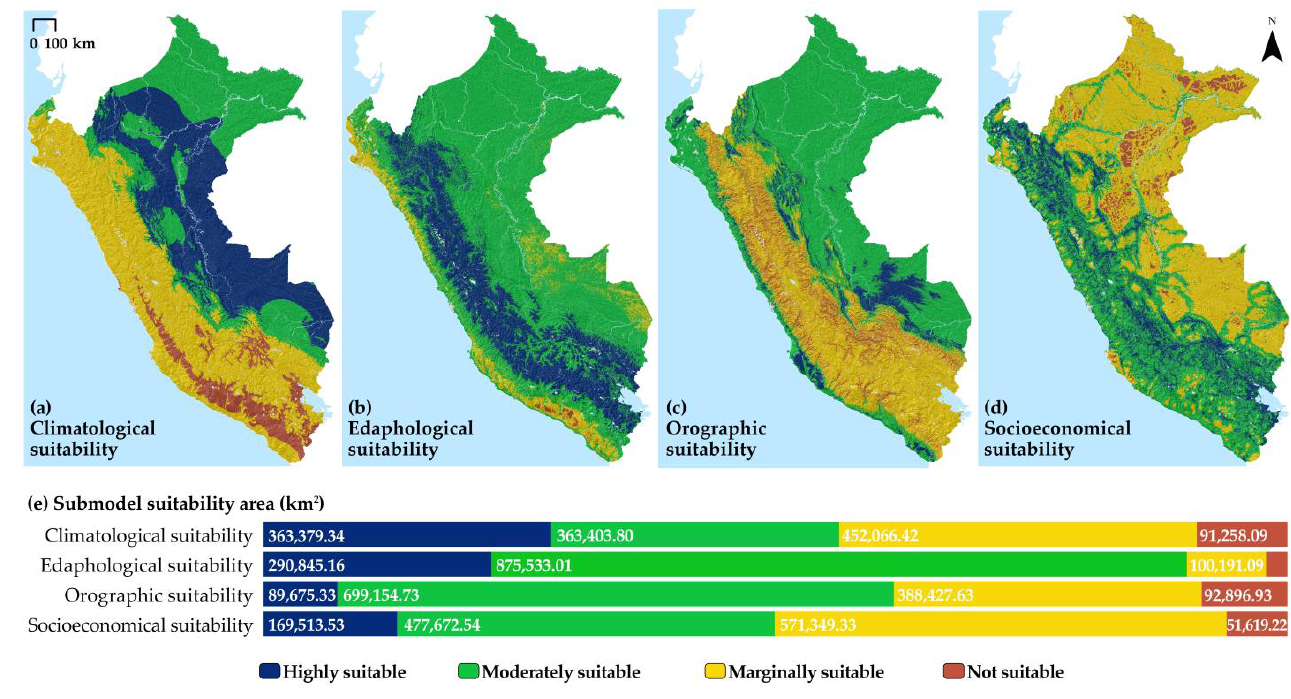
Figure 4. Suitability maps of edaphological ( a ), orographic ( b ), climatological ( c ) and socioeconomic ( d ) conditions, and ( e ) their respective areas, for cocoa cultivation in Peru.